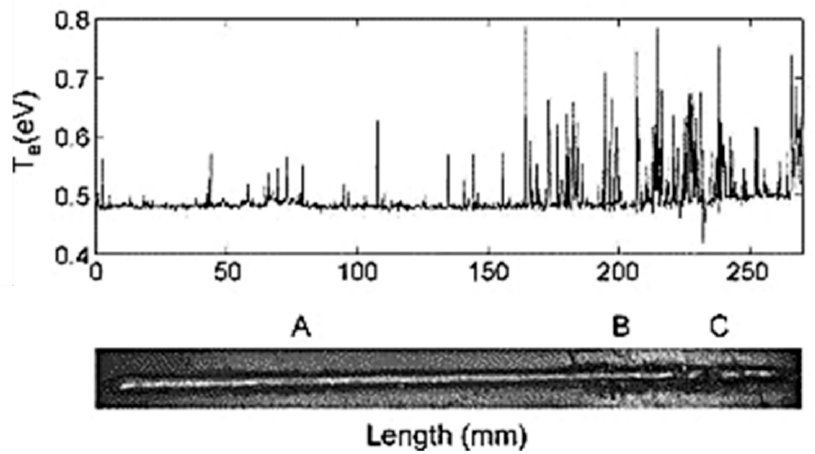
Figure 10. A schematic of the OES technique [95]. In this illustration, the recorded electronic temperature is correlated with the existing welding defects (A, B and C).